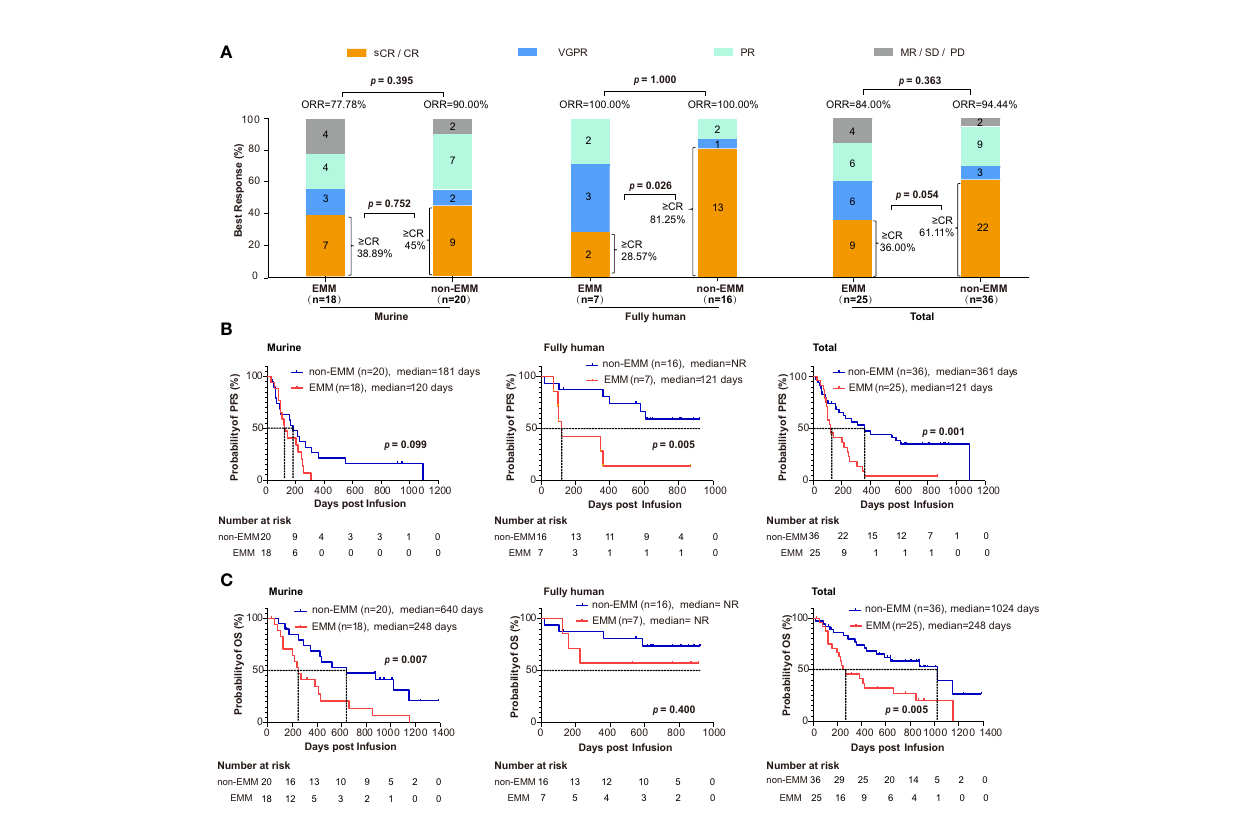
FIGURE 3 | Comparison of clinical response and survival analysis between EMM patients and non-EMM patients receiving anti-BCMA CART cell therapy in two clinical trials conducted in our center (A) ORR was analyzed between EMM and non-EMM. The p value is based on Fisher ’ s exact test. (B, C) Analysis of PFS and OS for EMM and non-EMM patients using the Kaplan-Meier method. P values less than 0.05 (two-tailed) were considered statistically signi fi cant. CR, complete response; EMM, extramedullary myeloma; ORR, objective response rate; MR, minimal response; NR, not reach; OS, overall survival; PD, relapse/progressive disease. PFS, progression-free survival; PR, partial response; sCR, stringent complete response; SD, stable disease; VGPR, very good partial